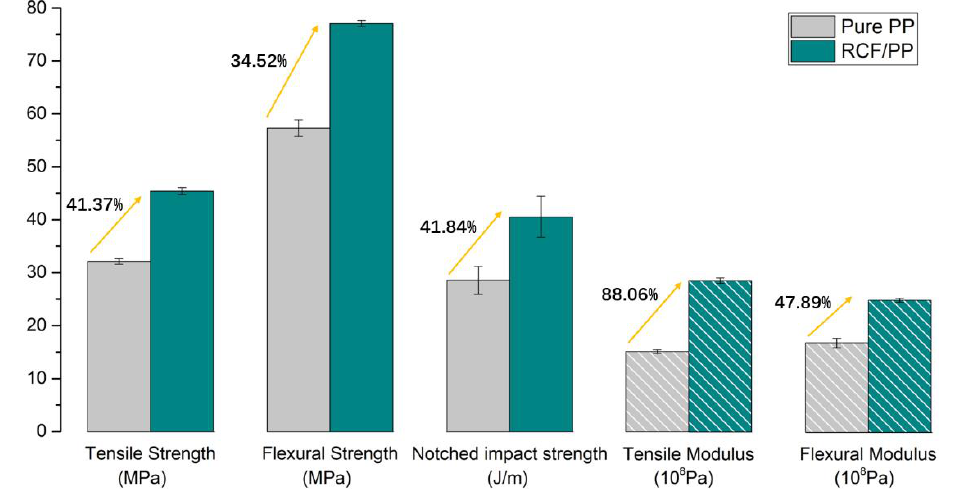
Figure 16. Mechanical properties of PP and PP/RCF.